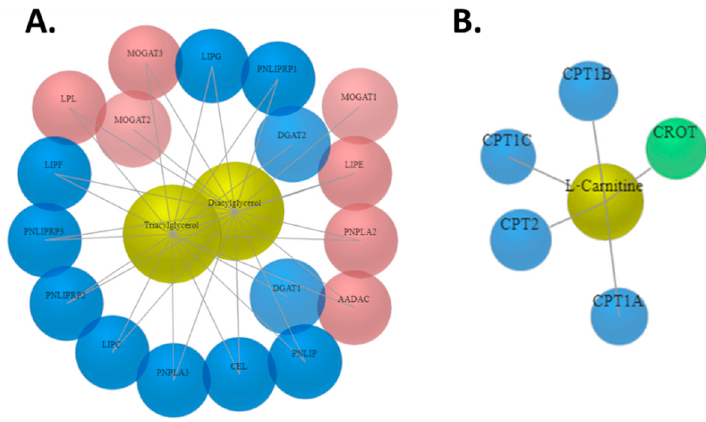
Figure A5. Reprogramming of metabolic pathways during adipogenic differentiation of MSCs. Numbers represent differences of proteomics-based reconstructed pathways (Recon2.4[57]) before and after MSC differentiation. A positive number indicates an increase of reactions in the pathway during differentiation, negative numbers indicate a decrease during differentiation. Differences were built from mean values of two replicates.